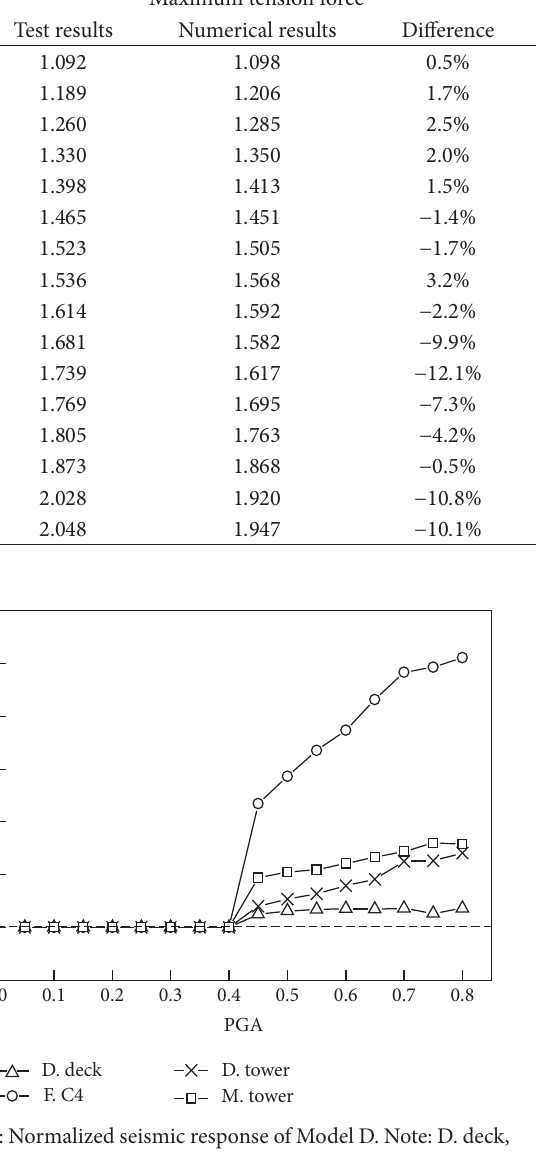
Figure 17: Normalized seismic response of Model D. Note: D. deck, deck displacement at deck end; D. tower, tower displacement at tower top; F. C4, maximum cable force of C4; M. tower, bending moment at tower